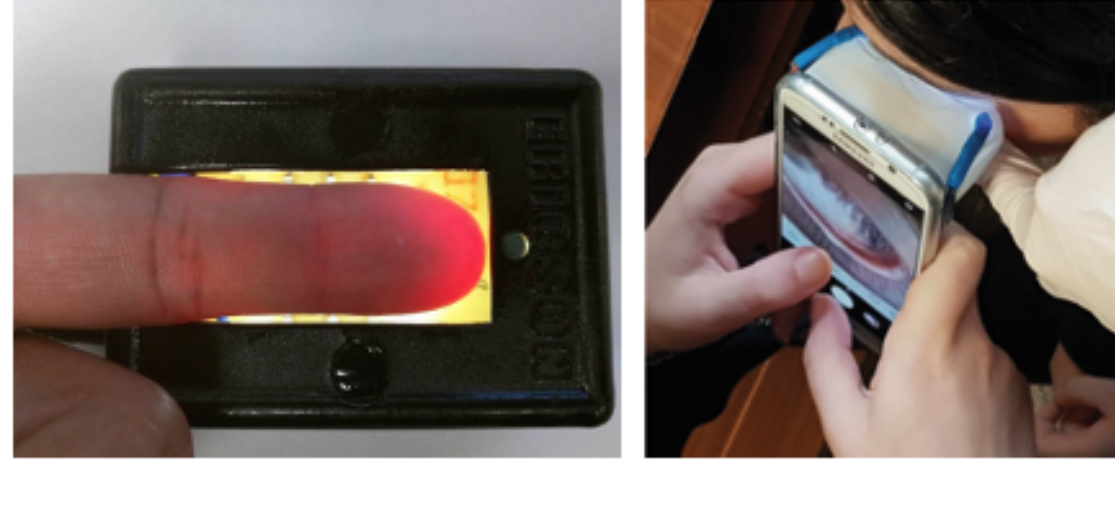
Figure 7. Recommended data collection tool design for (left) fingertip video capture and (right) an eyelid conjunctiva image.